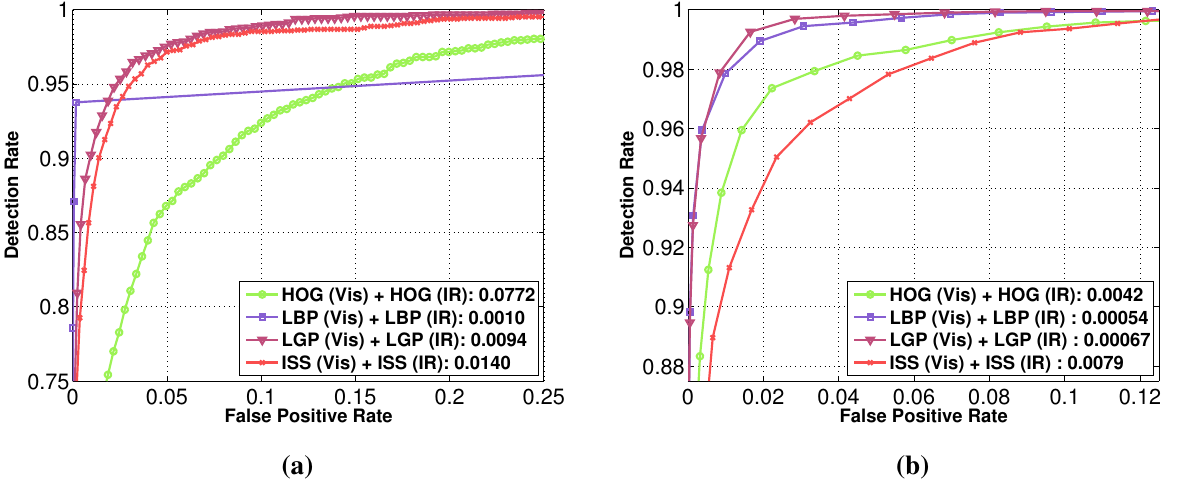
Figure 8. Individual feature fusion between the visible and FIR domains on: ( a ) the RIFIR dataset; ( b ) the ParmaTetravison dataset. The reference point is false positive rate obtained for a classification rate of